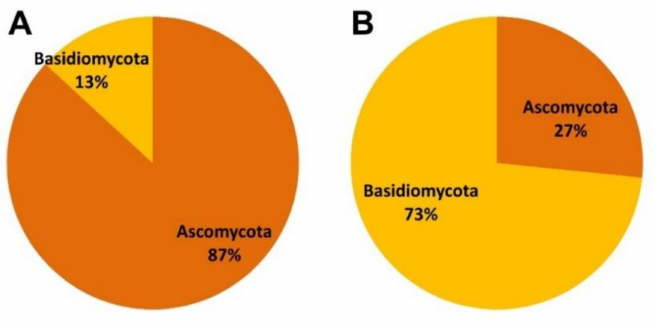
Figure 3. Relative abundance of mycorrhizal Ascomycota and Basidiomycota noted on 1-year-old ( A ) and 2-year-old ( B ) Scots pine seedlings in forest bare-root